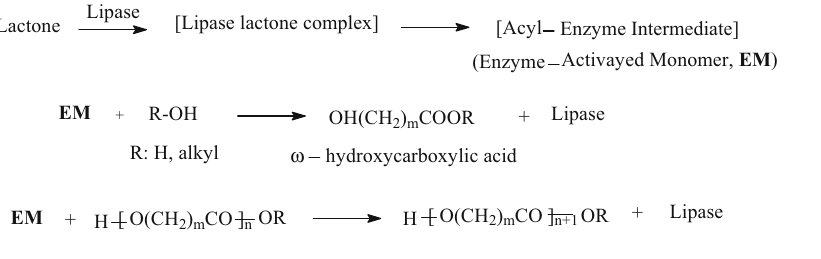
Figure 2: Reaction mechanism of the lipase - catalyzed ROP ( 23,24 )